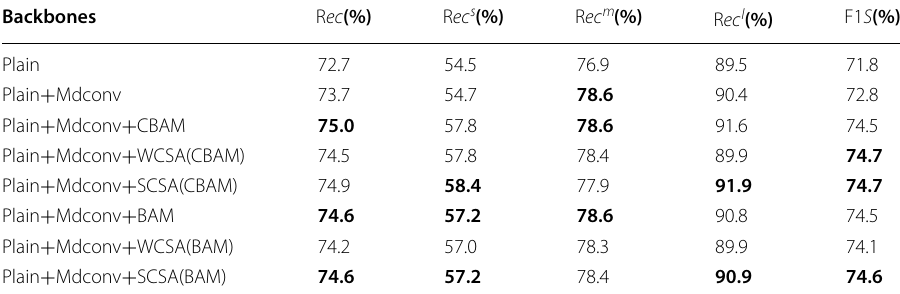
The significance for bold values is only highlighted on the best performance Table 4 Comparisons of recall (rec) and F1-score (F1S) on ResNet-50 and faster R-CNN with FPN Backbones